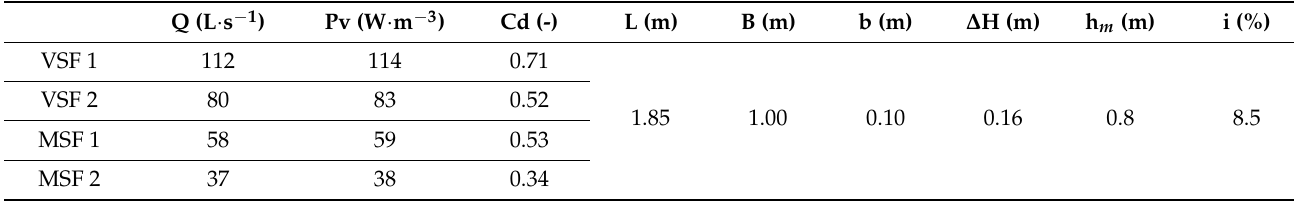
Table 1. Summary of the fishway configurations tested. Q, discharge; Pv, volumetric dissipation power; Cd, discharge coefficient; L, pool length; B, pool width; b, vertical slot width; ∆ H, head drop per pool; h m , pool mean water depth; I, fishway slope. VSF—vertical slot fishway; MSF—multislot fishway. ∆ H was 0.16 m; however, since the MSF has two slots per pool compared to a VSF, this head drop is divided into two, becoming approximately 0.08 m per